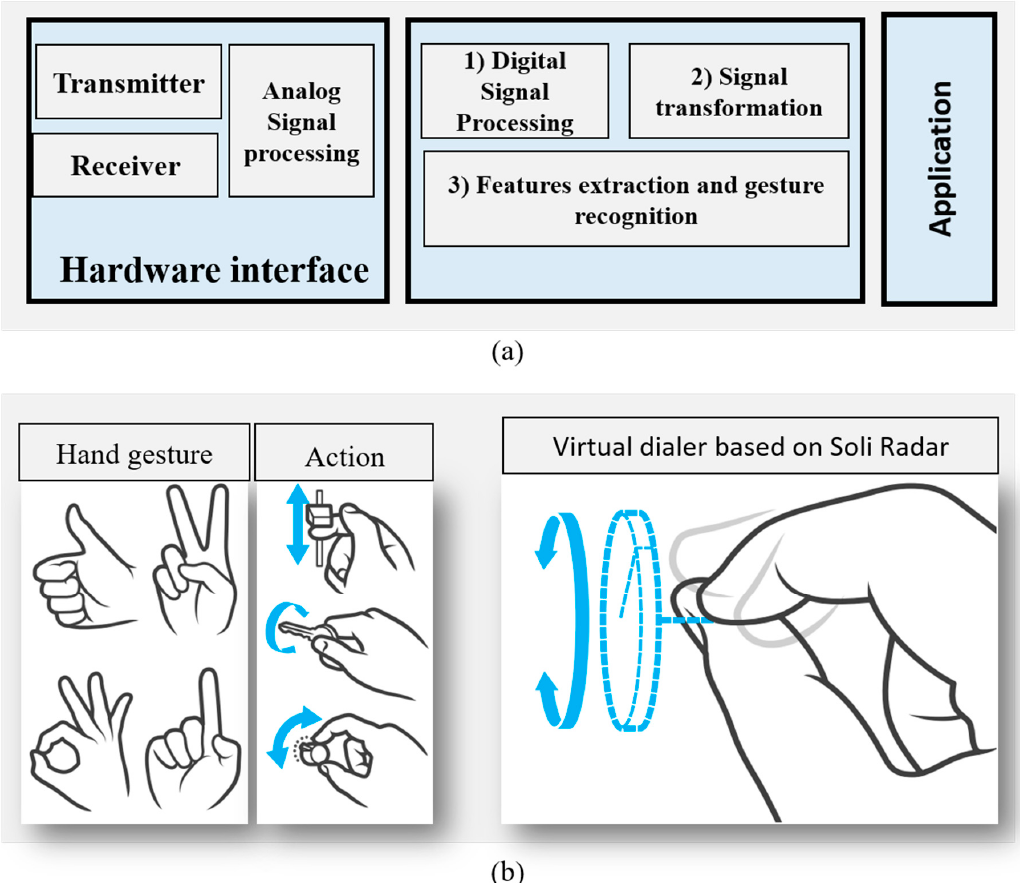
Figure 10. Google’s Soli Radar for gesture recognition. ( a ) Overall block diagram and pipeline of gesture-based HCI development ( b ) Exemplary demonstration of several gestures and their machine interfaces.